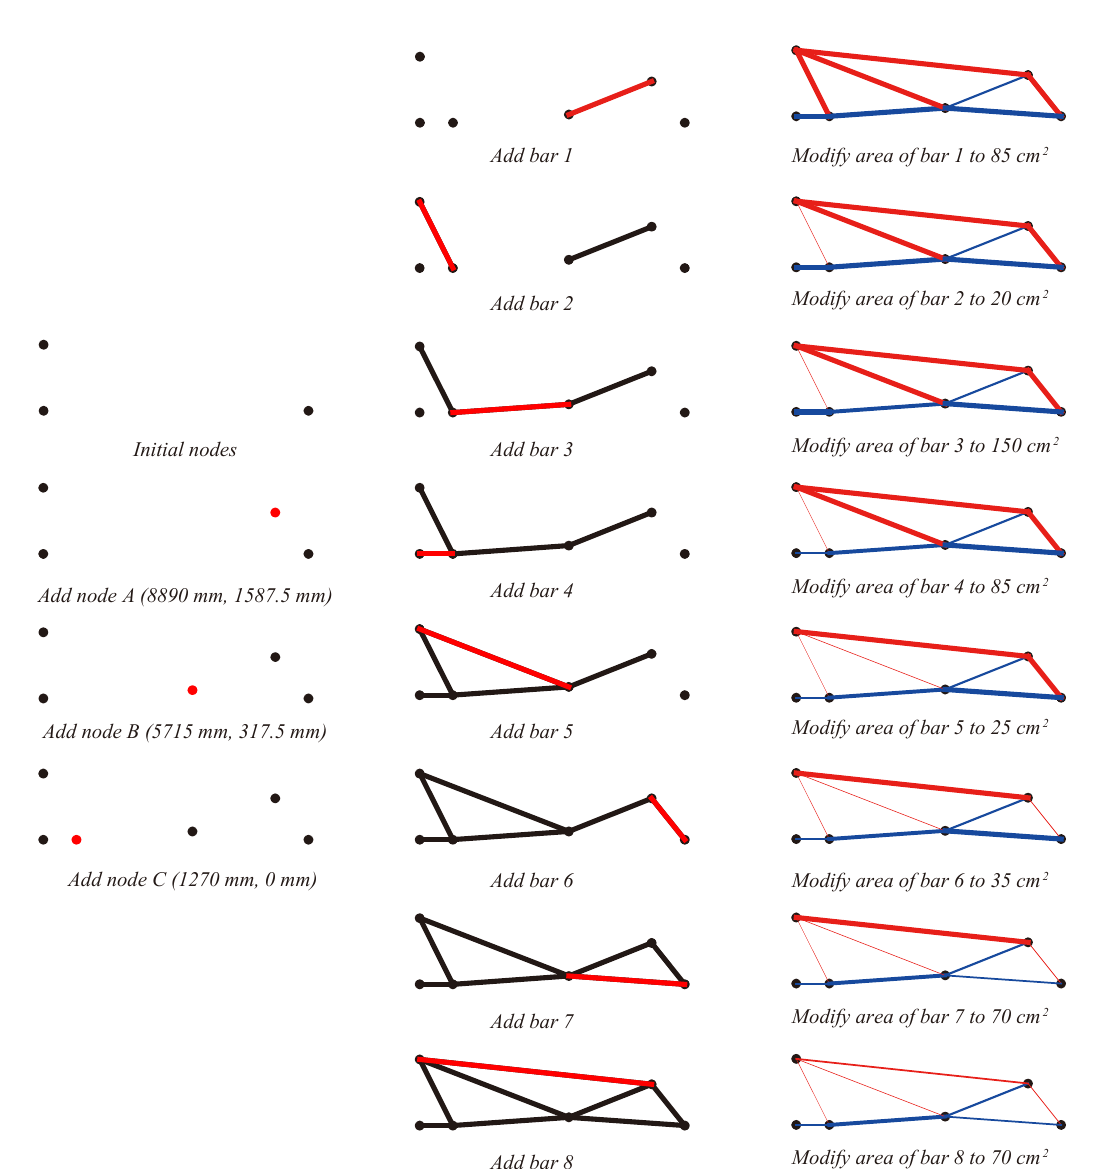
Figure 5. Action-taking process for constructing an optimal truss in stage I.